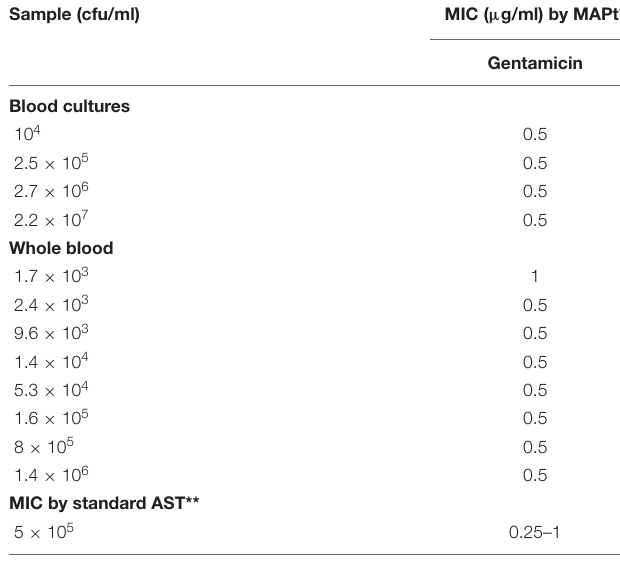
Frontiers in Microbiology |